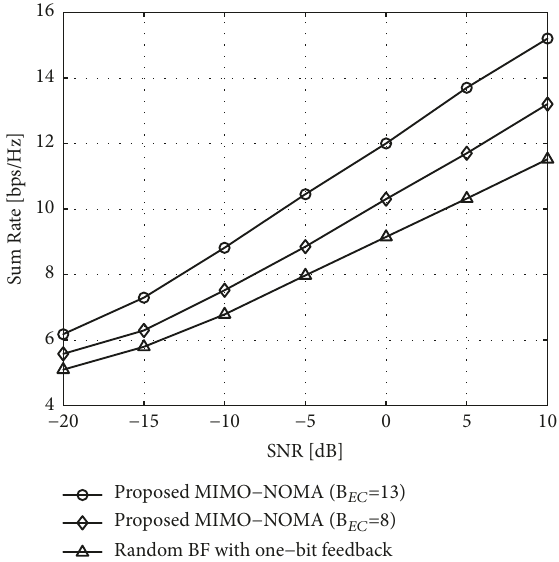
Figure 4: Sum rate performances of the proposed hybrid beam- forming and conventional NOMA-ZF against SNR ( 𝜇 =0.7; 𝜁 =0.2). CSI is assumed to be available at BS to generate beamforming